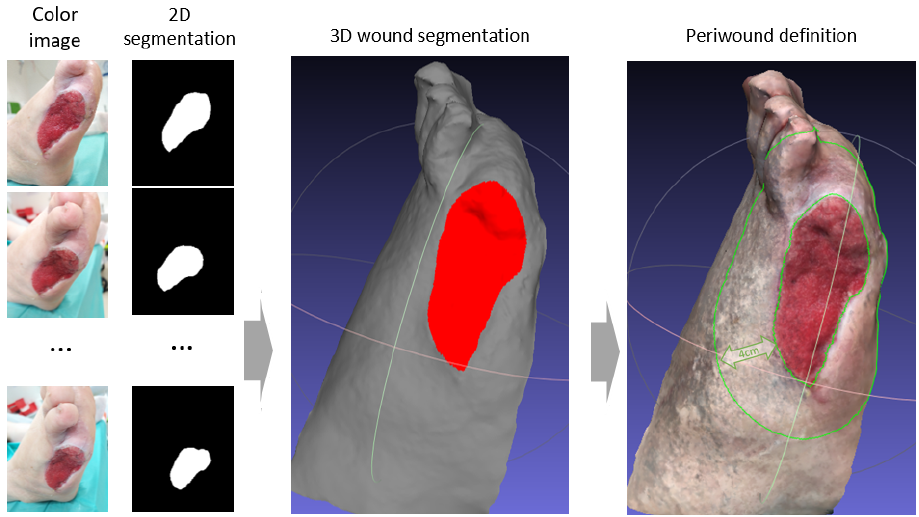
Figure 4. Illustration of the wound segmentation in 2D, as well as the definition of the wound and periwound area in the 3D